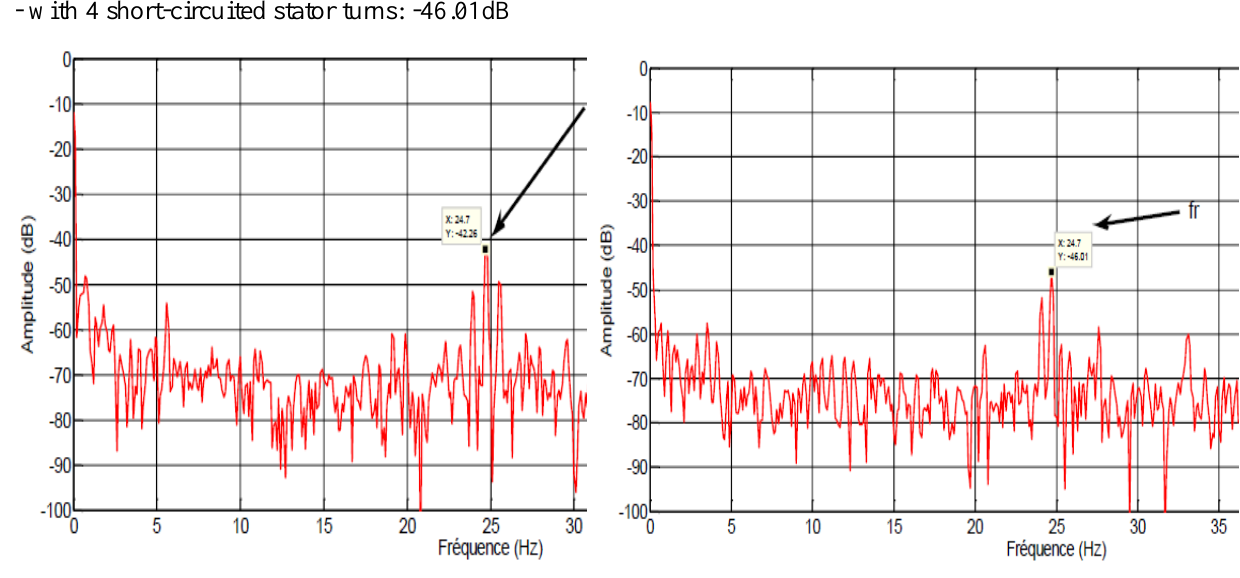
Figure 10. Experimental logarithmic spectrum of the HPVPA of a motor with 4 short-circuited stator turns at full load